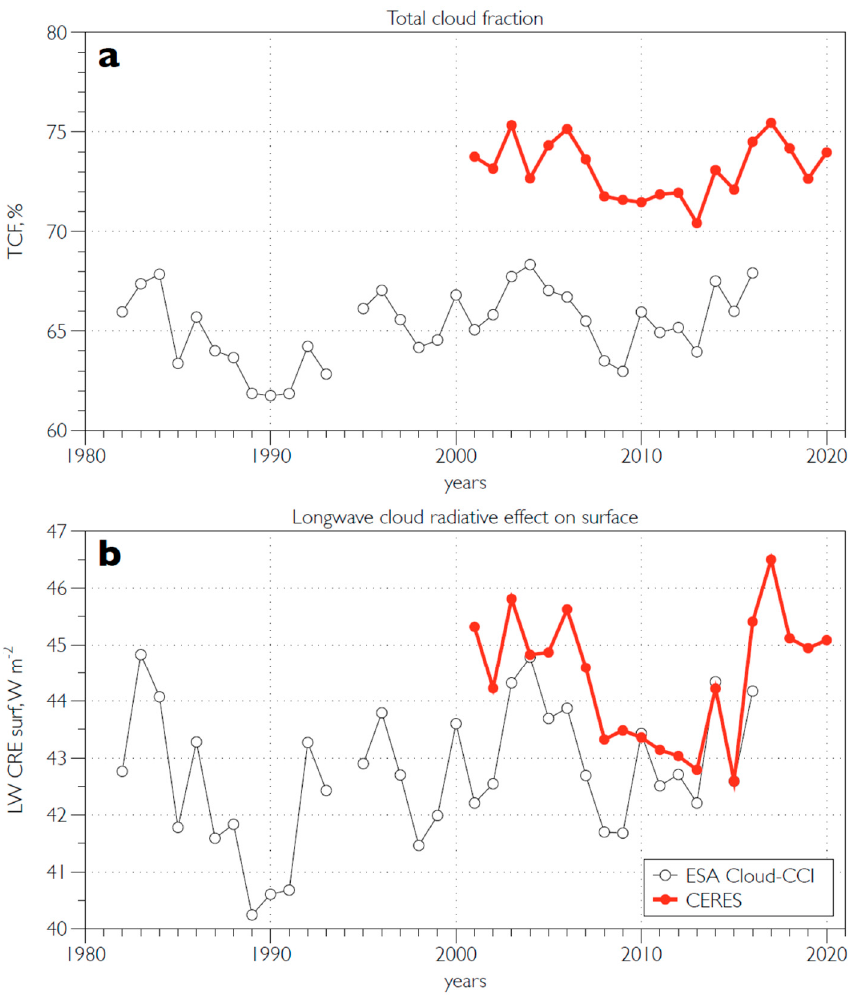
Figure 7. Variations in the total cloud cover ( a ) and the longwave cloud radiative effect on the surface ( b ) obtained from ESA Cloud-CCI and CERES data products.